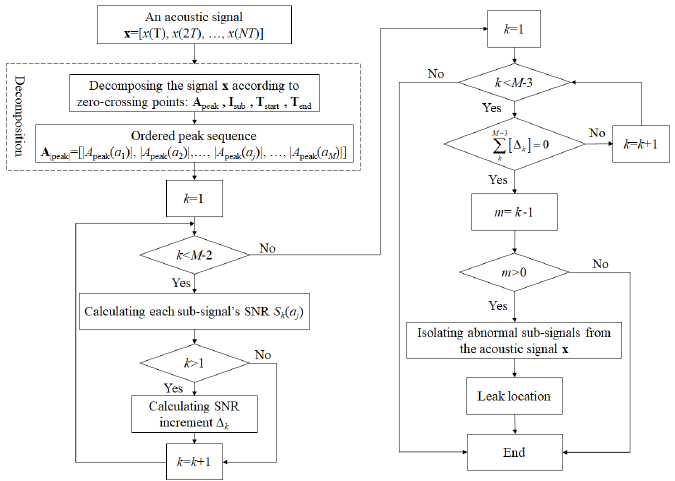
Figure 10. Flow chart of the model-free abnormal acoustic signal isolation